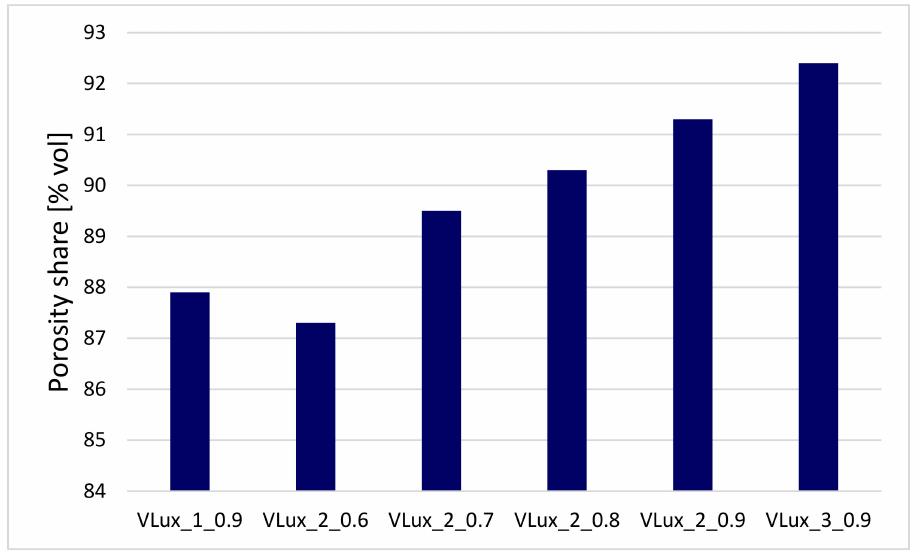
Figure 8. The results of the total porosity analysis of foams with different water content performed at INCO = 0.9 and of foams with different INCO containing 2 php of water were obtained during the analysis with the use of µ